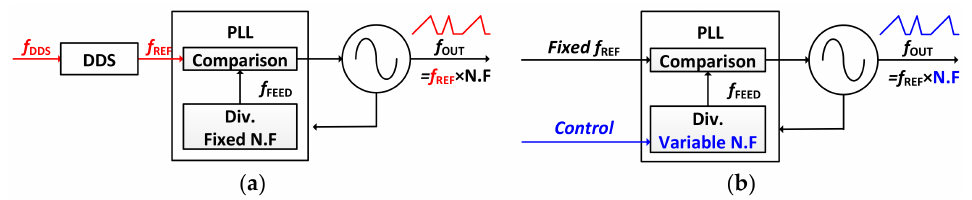
Figure 4. General structure of a dual-mode LO using PLL. ( a ) Reference clock modulation method; ( b ) Division ratio control